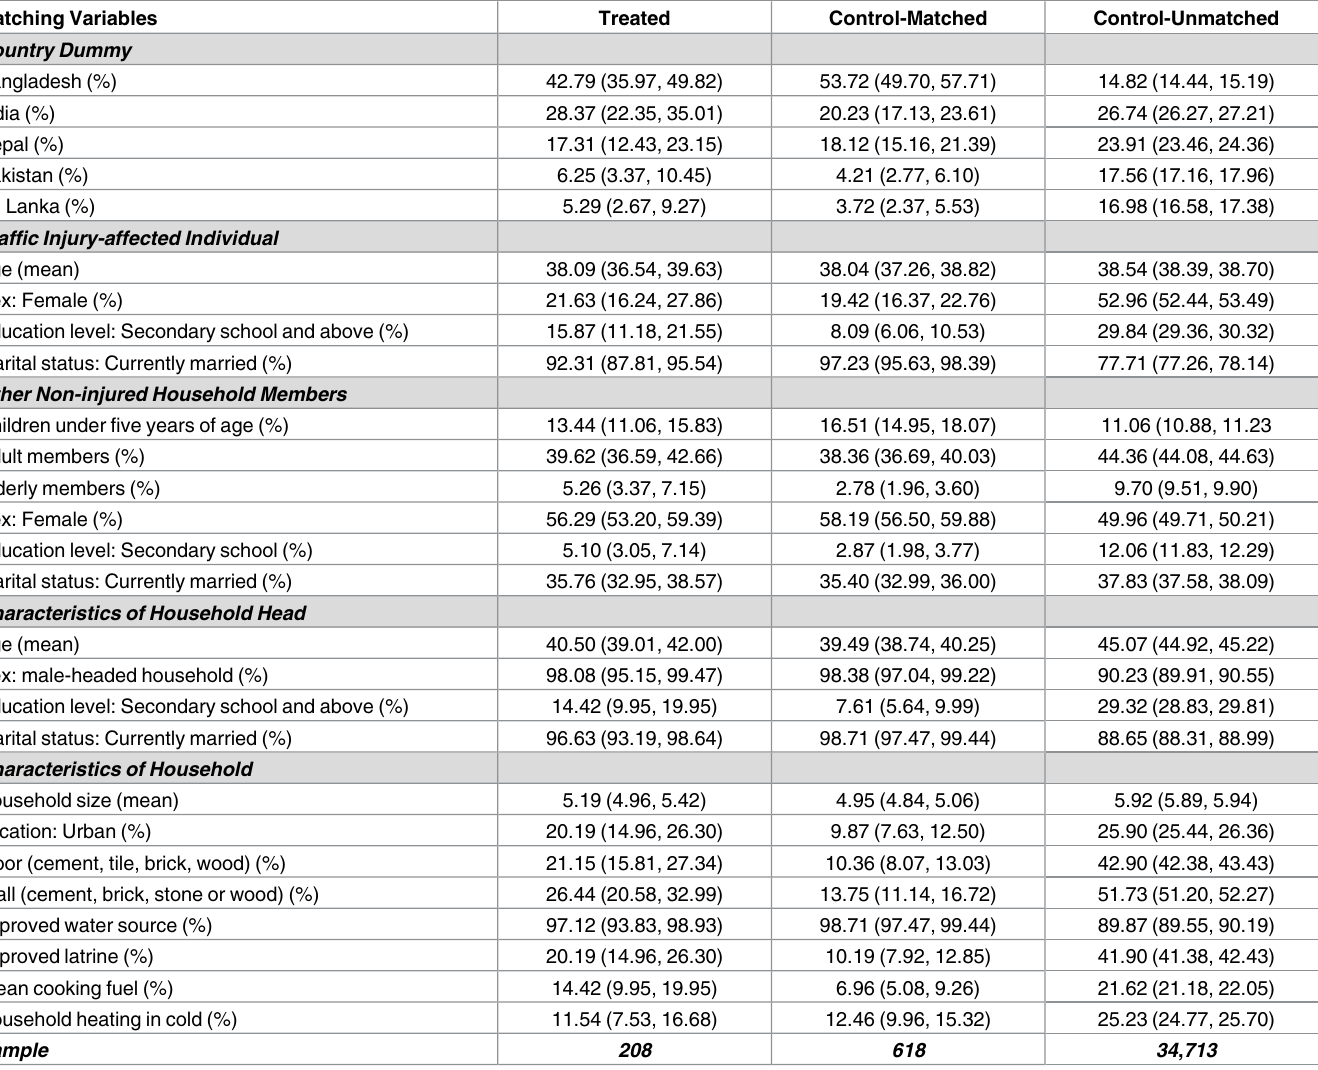
Table 1. Summary of matching variables by traffic injury-affected and control households, South Asia, 2003. Matching Variables Treated Control-Matched